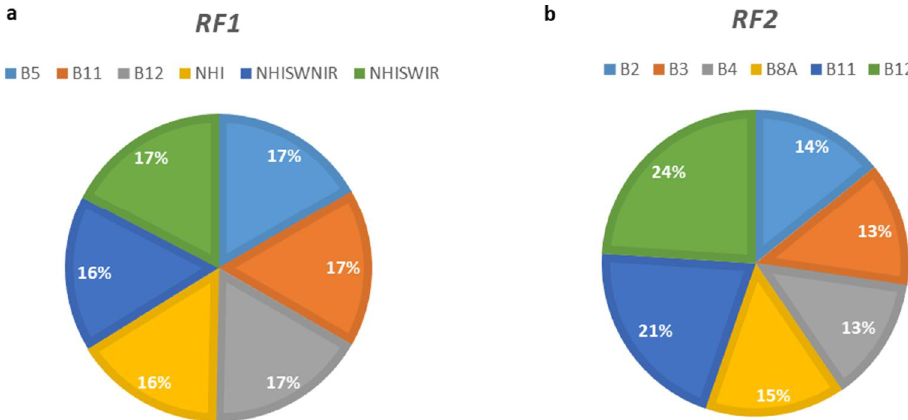
Figure 4. Feature importance related to the models RF1 ( a ) and RF2 ( b ).